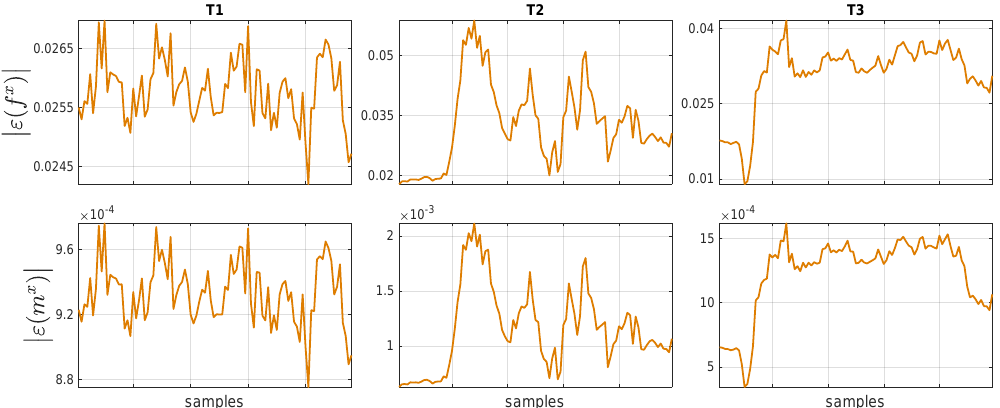
Figure 12. Norm of the error of the overall set of the overall external forces ε ( f x ) [ N] and the moments ε ( m x ) [ Nm] between the estimation with the fixed-base and the floating-base MAP, for tasks T1, T2 and